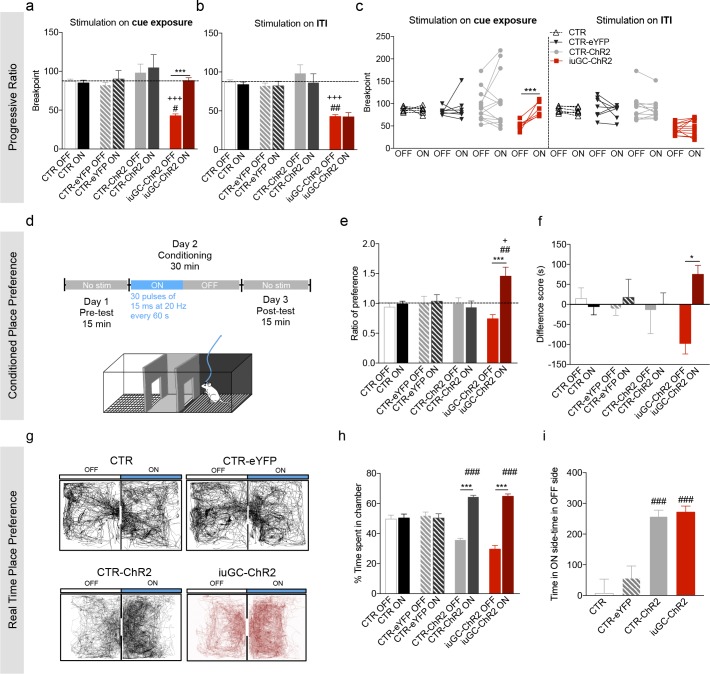
Optogenetic activation of LDT-VTA rescues motivational deficits of iuGC-ChR2 animals and induces conditioning.(a) Optogenetic stimulation of LDT terminals in the VTA during cue exposure (30 pulses of 15 ms at 20 Hz) rescues the breakpoint deficits in the PR test of iuGC-ChR2 animals, with no effect in other groups (nCTR = 6; nCTR-eYFP = 7; nCTR-ChR2 = 13; niuGC-ChR2 = 12). (b) Activation of LDT terminals in the VTA in an irrelevant period, such as for example during inter-trial interval (ITI) does not change breakpoint of iuGC-ChR2 animals. (c) Individual performance in the PR test. All iuGC-ChR2 animals increase their breakpoint when stimulation is associated with the cue but not during the ITI. (d) Schematic representation of the CPP protocol. Laser stimulation (30 pulses of 15 ms at 20 Hz, every 60 s) is associated to one chamber. (e) Optogenetic stimulation of LDT terminals in the VTA increases preference for the stimulation-paired box (ON) in iuGC-ChR2 but not in CTR-eYFP nor CTR-ChR2 animals (nCTR = 6; nCTR-eYFP = 7; nCTR-ChR2 = 5; niuGC-ChR2 = 6). (f) Difference score of CPP protocol shown as the difference in time spent in pre- and post-test. iuGC-ChR2 animals present a shift in preference for the ON chamber. (g) Real Time Place Preference (RTPP) protocol: animals were placed in a box with two identical chambers for 15 min and allowed to freely explore. When animals crossed to the ON side, optical stimulation was given until exiting the chamber. Shown are representative tracks from a CTR, CTR-eYFP, CTR-ChR2 and an iuGC-ChR2 animal. (h) CTR-ChR2 and iuGC-ChR2 rats spend a significantly higher percentage of time in the stimulation-associated box (ON side) (nCTR = 6; nCTR-eYFP = 7; nCTR-ChR2 = 8; niuGC-ChR2 = 6). (i) Difference between time spent in the ON versus OFF side. Data represented as mean ±s.e.m. *p<0.05, **p<0.001, ***p<0.0001. #: comparison with CTR-eYFP; +: comparison with CTR-ChR2. Additional data is depicted in Figure 4—figure supplements 1–3.